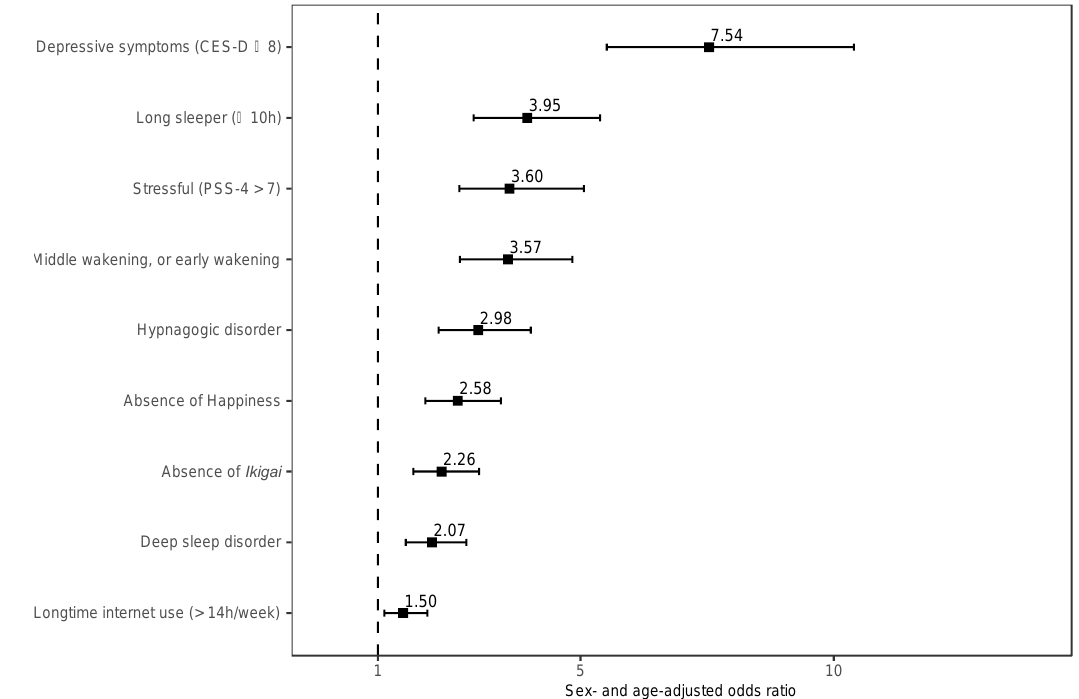
Figure 2. Sex- and age-adjusted odds ratios of participants with schizophrenia compared to participants without schizophrenia in terms of psychiatric comorbidities. Abbreviations: CES-D, a modified 11-item Center for Epidemiological Studies Depression Scale; PSS-4, a 4-item Perceived Stress Scale.